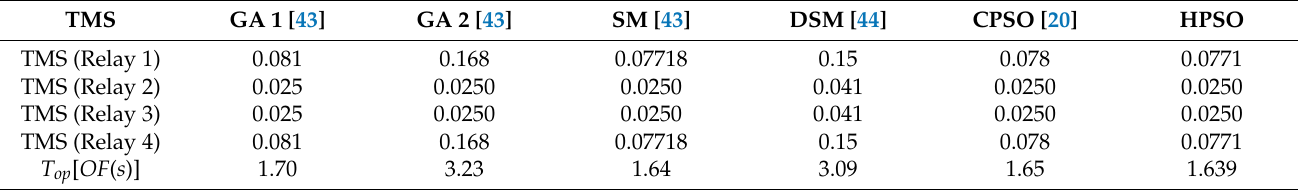
Table 3. Comparison of the optimized TMS with other techniques (case